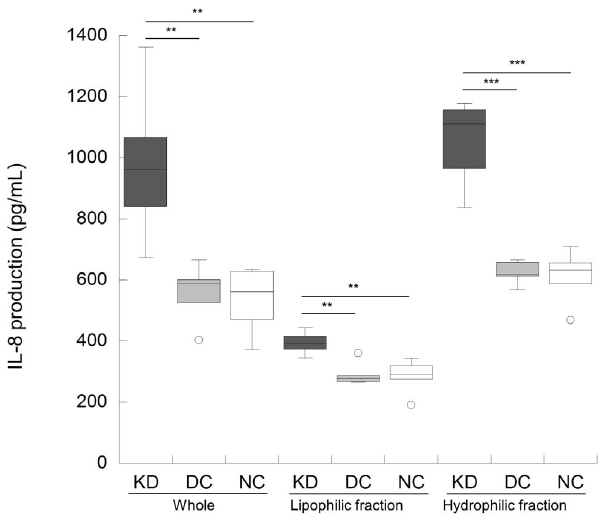
Figure 1. Whole and fractionated serum samples from KD patients induce cytokine production in HCAECs. The production of IL-8 by HCAECs was measured in triplicate after 24-hour stimulation with whole sera or lipophilic and hydrophilic fractions from KD patients (n=6), DC controls (n=5; pneumonia; n=2, influenza A virus infection; n=1, adenovirus infection; n=1 and urinary tract infection; n=1), or NC subjects (n=5). Lipophilic and hydrophilic fractions were separated by ethyl acetate extraction. The bottom and top edges of the box plot correspond to the 25th and 75th percentiles, respectively. The horizontal line inside the box represents the median of the distribution. The whiskers indicate the 10th and 90th percentiles. ** P , 0.01; *** P , 0.001 (Welch’s t